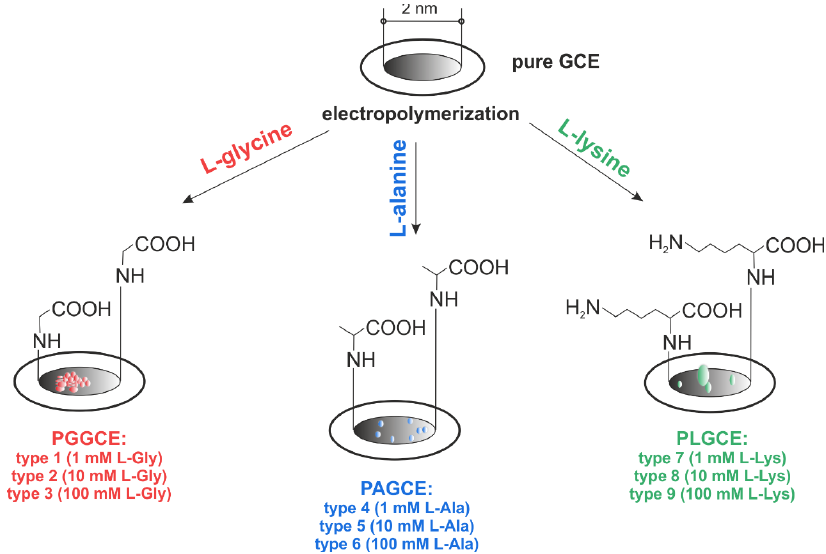
Figure 3. Modifications of GC electrodes: PGGCE (types 1 – 3), PAGCE (types 4 – 6), PLGCE (types 7 – 9).